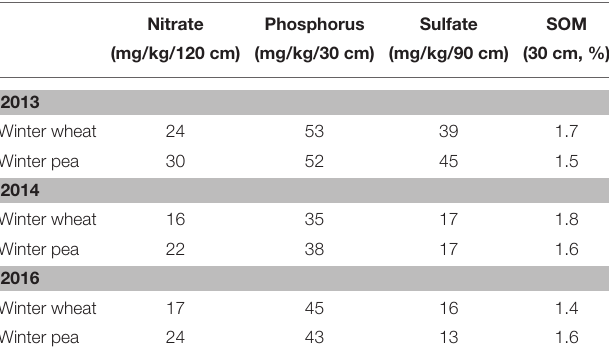
TABLE 1 | Soil nitrate-N, Olsen-P, sulfate-S, and soil organic matter (SOM) in late March during 3 years after either winter pea or winter wheat and prior to planting spring